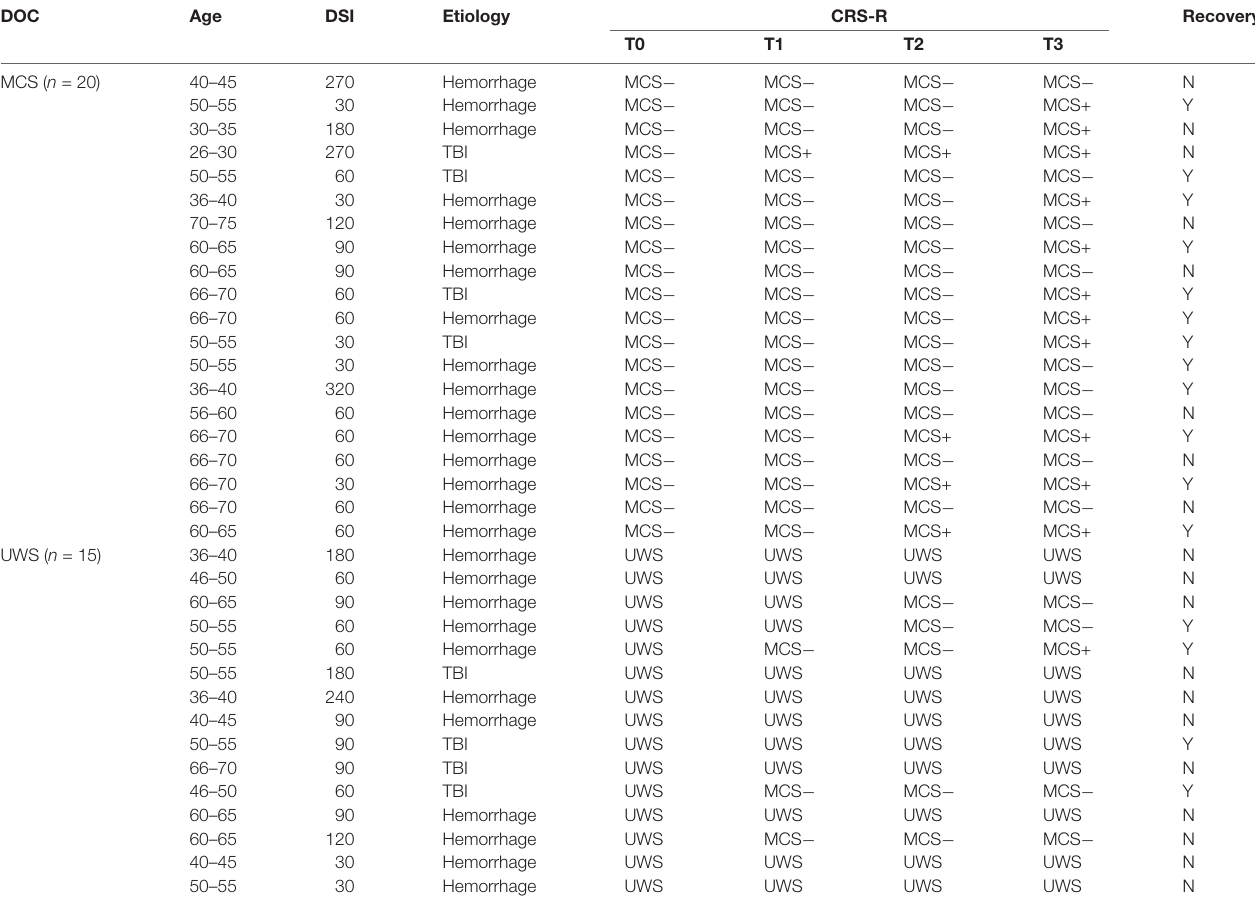
TABLE 1 | Demographics and clinical data of the included